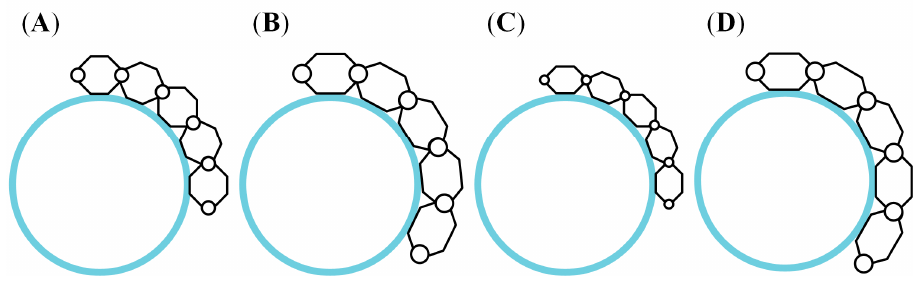
Figure 11. The snake-like robot whose joint module is designed based on the optimization cases: ( A ) case 1; ( B ) case 2; ( C ) case 3; and ( D ) case 4.